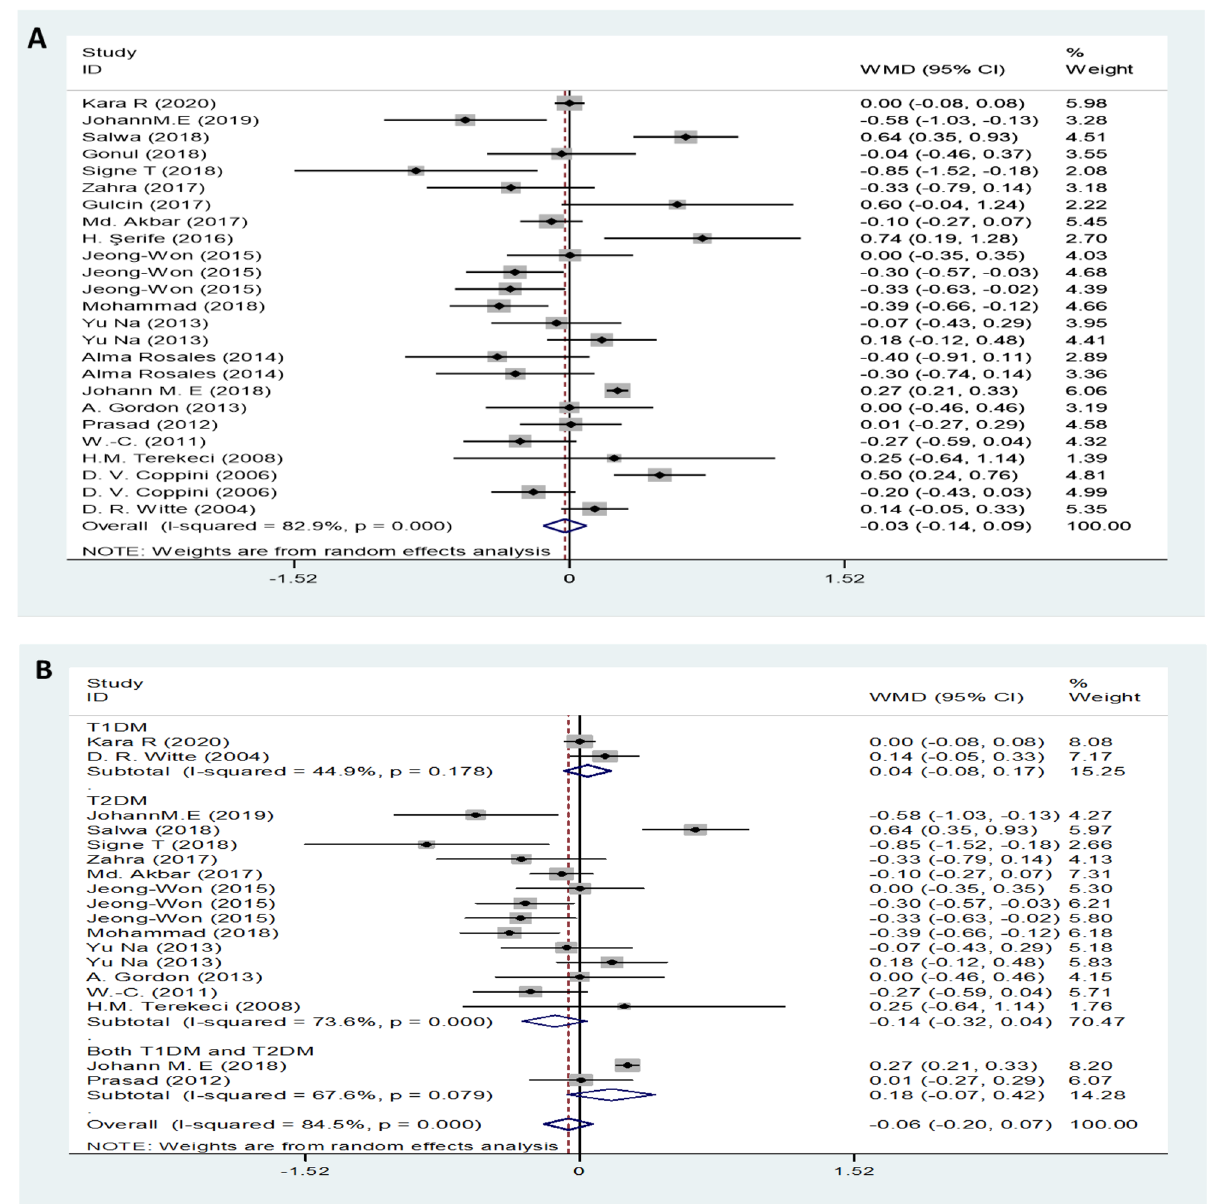
Figure 3. TC levels ( A ) in people with DN versus those without DN. TC levels in the subgroup analysis stratified by the type of diabetes ( B ) and symptom severity ( C ). OR ( D ) for DN in patients according to serum TC